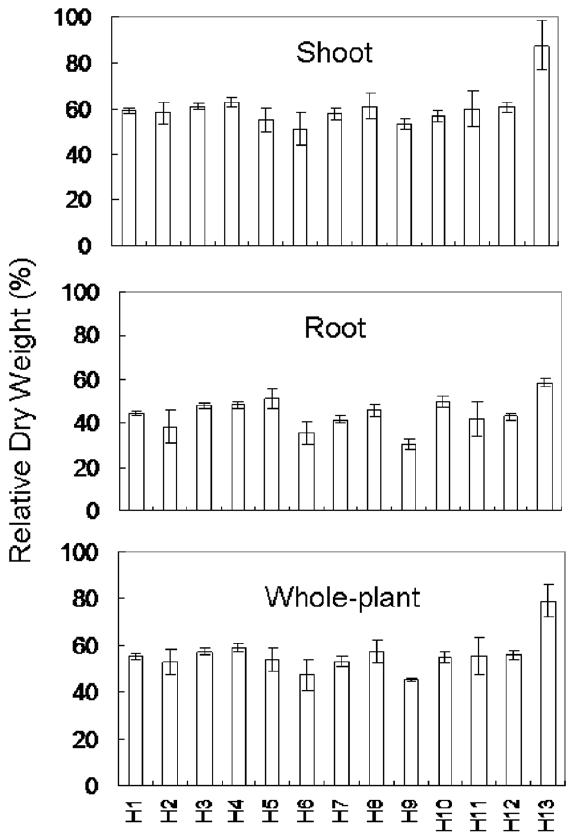
Figure 5. The effects of salt stress on the relative dry weight for thirteen haplotypes. Each bar is the mean of relative dry weight (shoot, root and whole-plant) of accessions belonging to the corresponding haplotype. Error bars are SE.